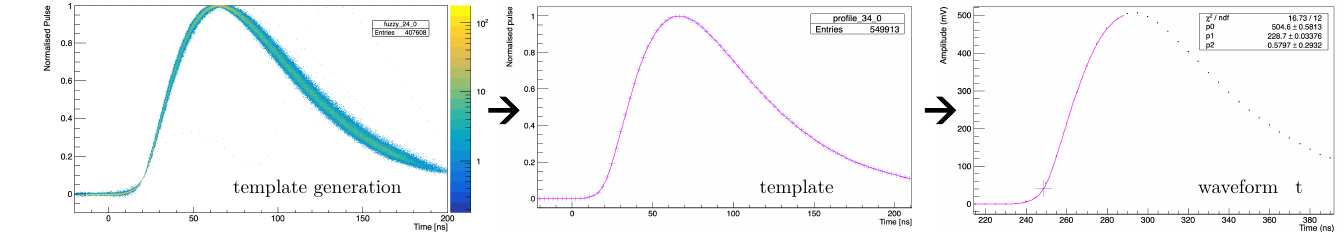
Figure 4. Example of template generation and waveform fitting for a calorimeter channel.